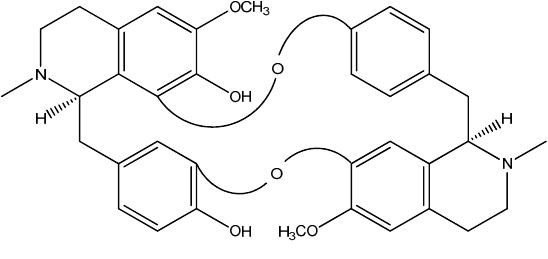
Figure 1. Chemical structure of